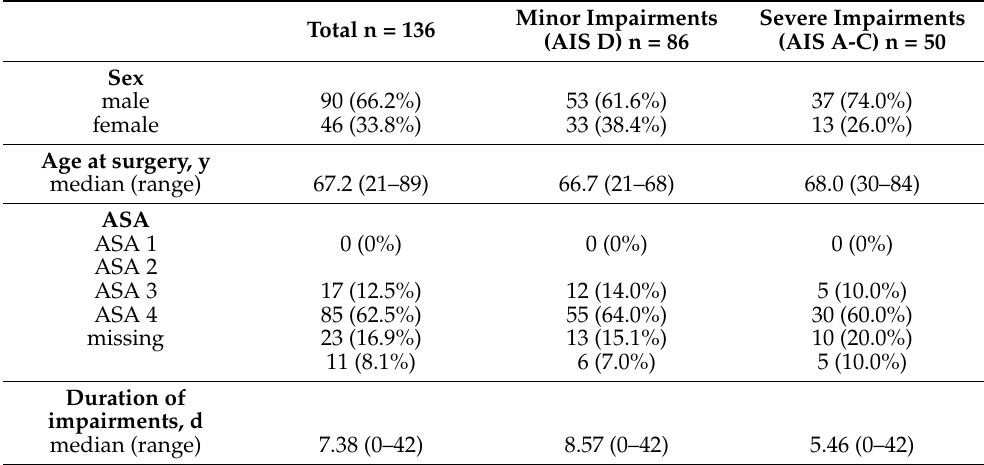
Table 1. Patients’ characteristics.